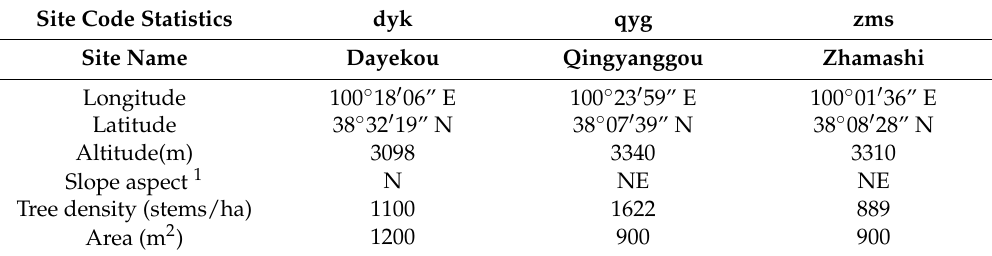
Figure 1. Location map of the study area showing the position and topography of sampling sites and nearest meteorological stations in the upper reaches of the Heihe river. Table 1. The information of fixed sampling plots at the upper reaches of the Heihe river.